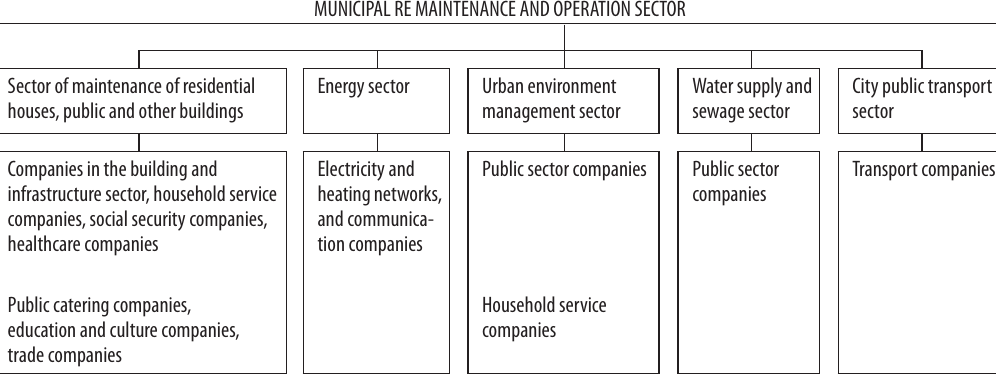
Fig. 3. Organization of municipal RE maintenance and operation activity (with reference to Lepkova, Vilutiene